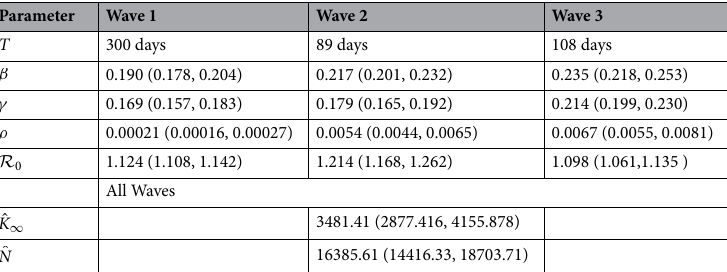
Table 2. Parameter estimates. Wave-specific posterior estimates (means and 95% credibility bounds) from the parametric model in equation (3).